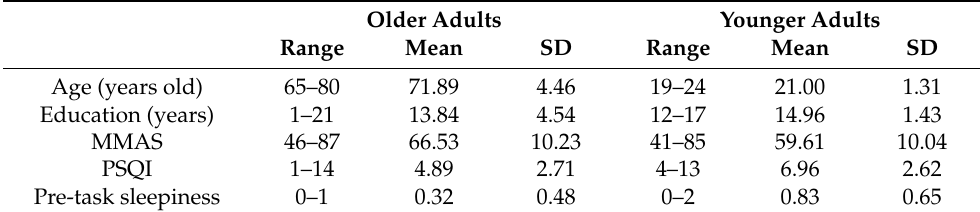
Table 1. Demographic information of participants.